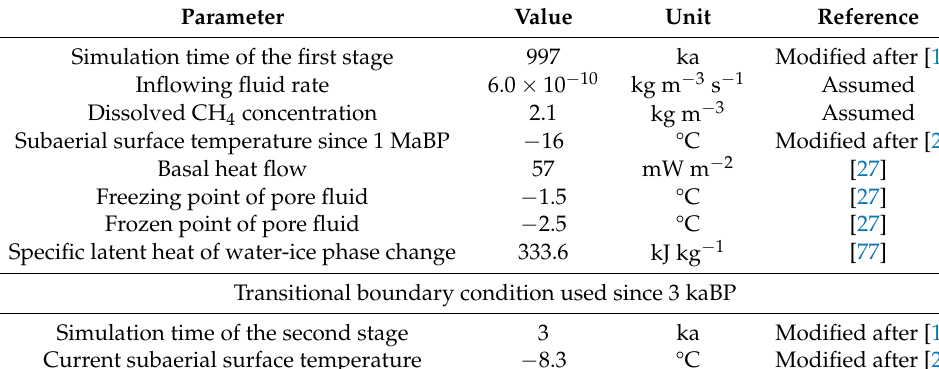
Table 3. List of applied initial and boundary conditions in the simulation.